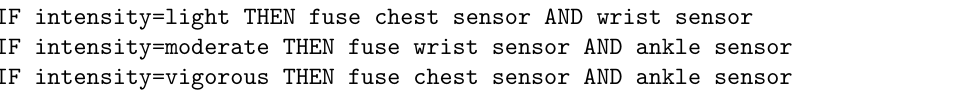
Table 3. Rules’ extraction for the intensity of